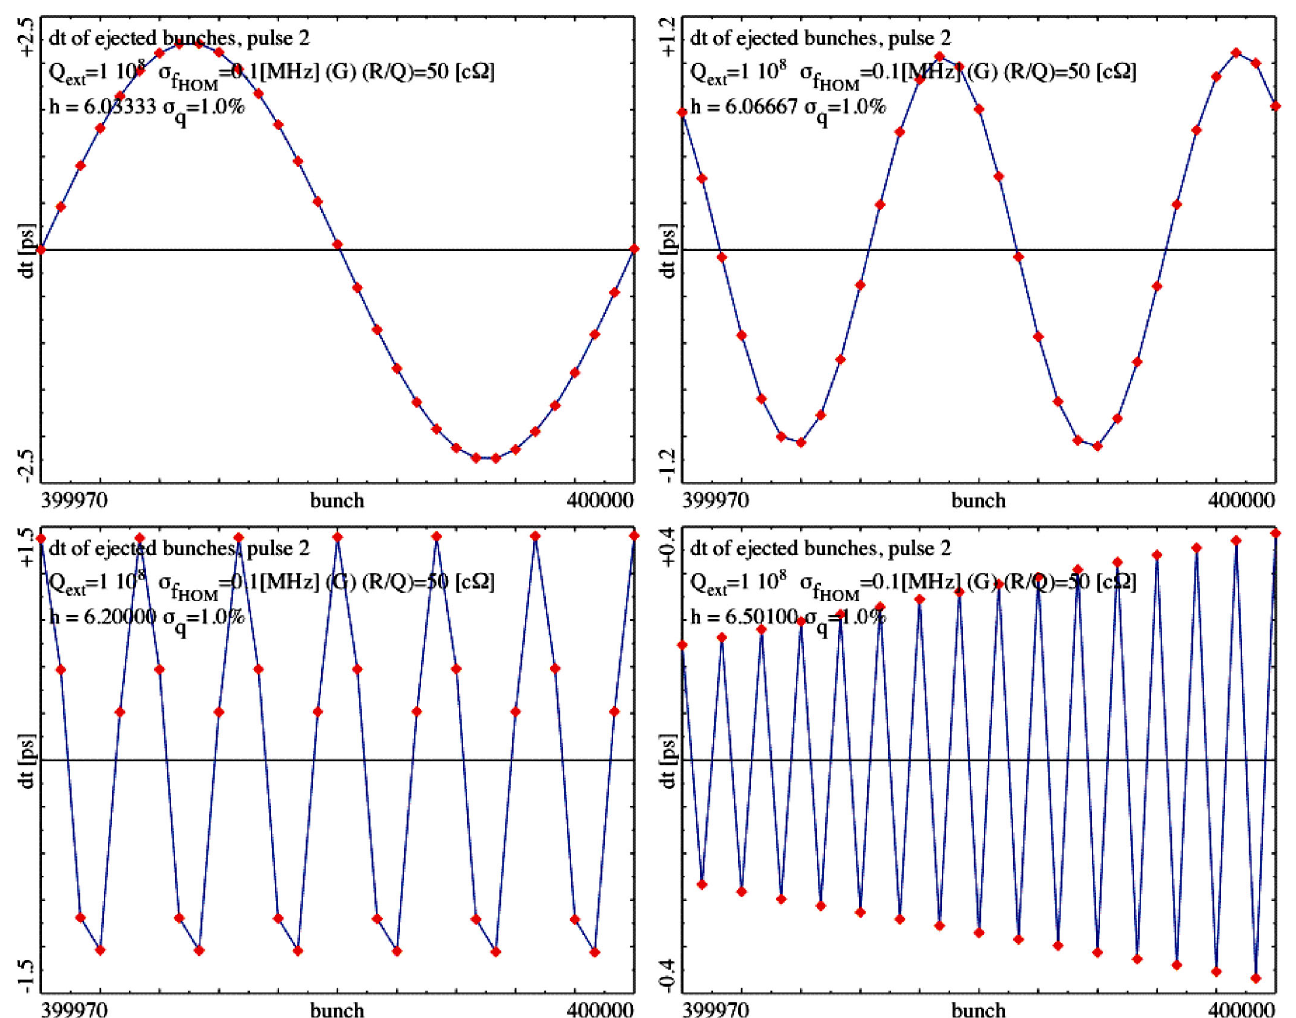
BEAM SIMULATIONS WITH INITIAL . .